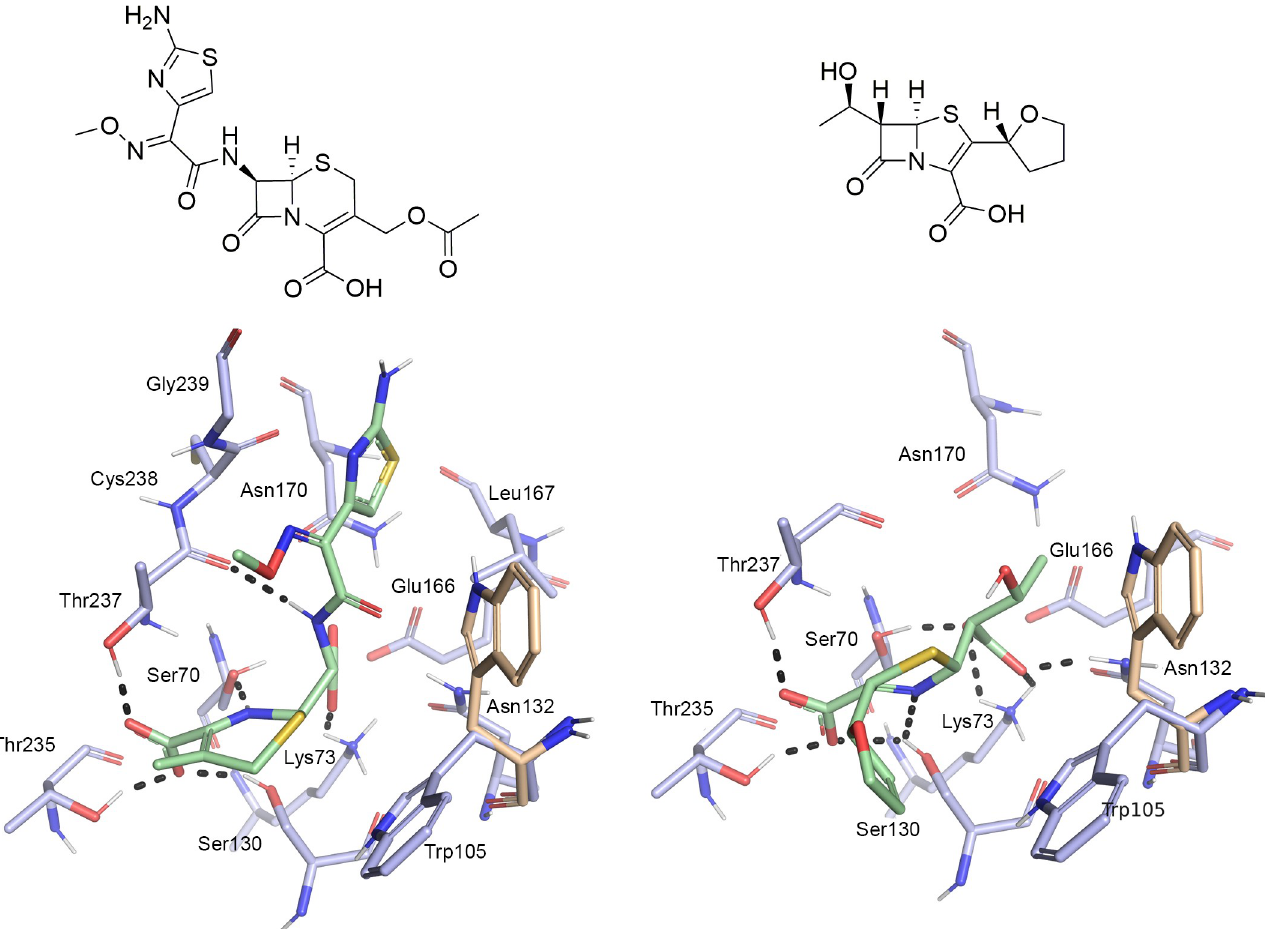
Fig 2. Structures and binding modes of hydrolyzed β -lactam antibiotics in the KPC-2 binding site. Left: binding mode of hydrolyzed cefotaxime (PDB code 5UJ3). Right: binding mode of hydrolyzed faropenem (PDB code 5UJ4). The second rotamer of Trp105 adopted in the apo-enzyme is coloured in beige, protein side chains in blue and ligands in green. Hydrogen bonds are indicated as black